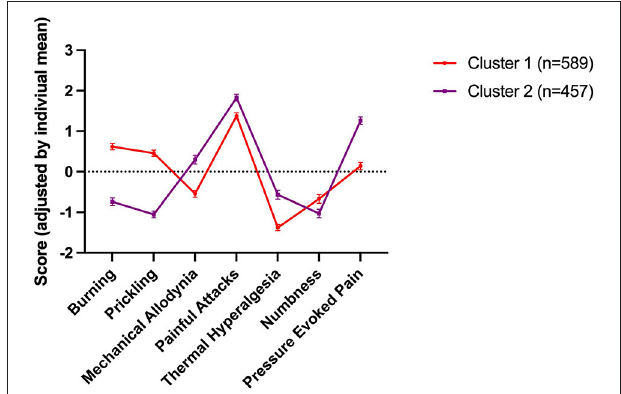
FIGURE 2 | Sensory symptom profile of the two clusters. Scores were individually mean adjusted. The cluster model had a silhouette measure of cohesion and separation of 0.3, indicating it was of a “fair” quality. 56.3% of patients fell into cluster 1 ( n = 589), and 43.7% in cluster 2 ( n = 457). The symptoms with the greatest predictive importance were “prickling/tingling” (predictive importance = 1), and “burning” (predictive importance = 0.77), which were most characteristic for cluster 1. In contrast, “pressure evoked pain” (predictive importance = 0.48), “thermal hyperalgesia” (predictive importance = 0.27) and “mechanical allodynia” (predictive importance = 0.27) were more common in cluster 2. “Painful attacks” (predictive importance = 0.11) and “numbness” (predictive importance = 0.05) were least